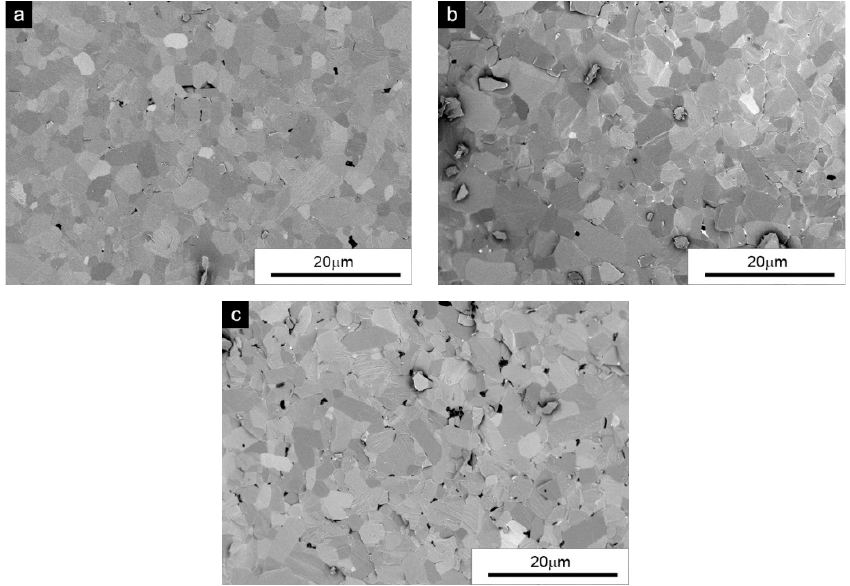
Figure 4. Microstructure of SiC sinters’ fractures for the starting powders with an α / β ratio of 80/20: ( a ) carbon-free SiC, ( b ) SiC-G graphene addition and ( c ) SiC-CB carbon black addition.